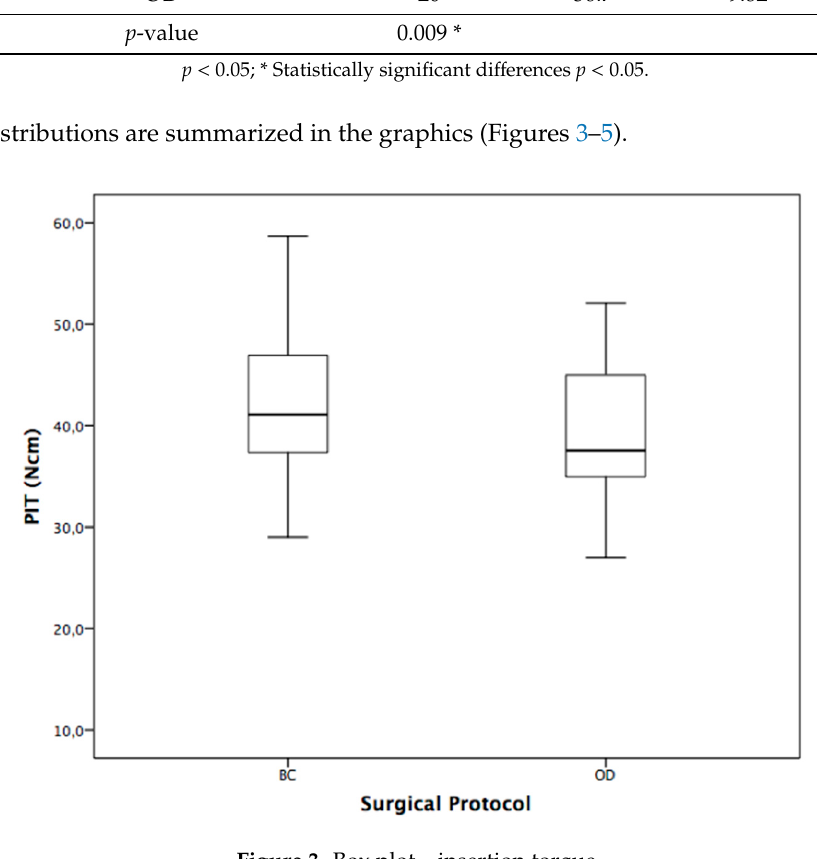
Figure 3. Box plot—insertion Figure 3. Box plot—Insertion torque.